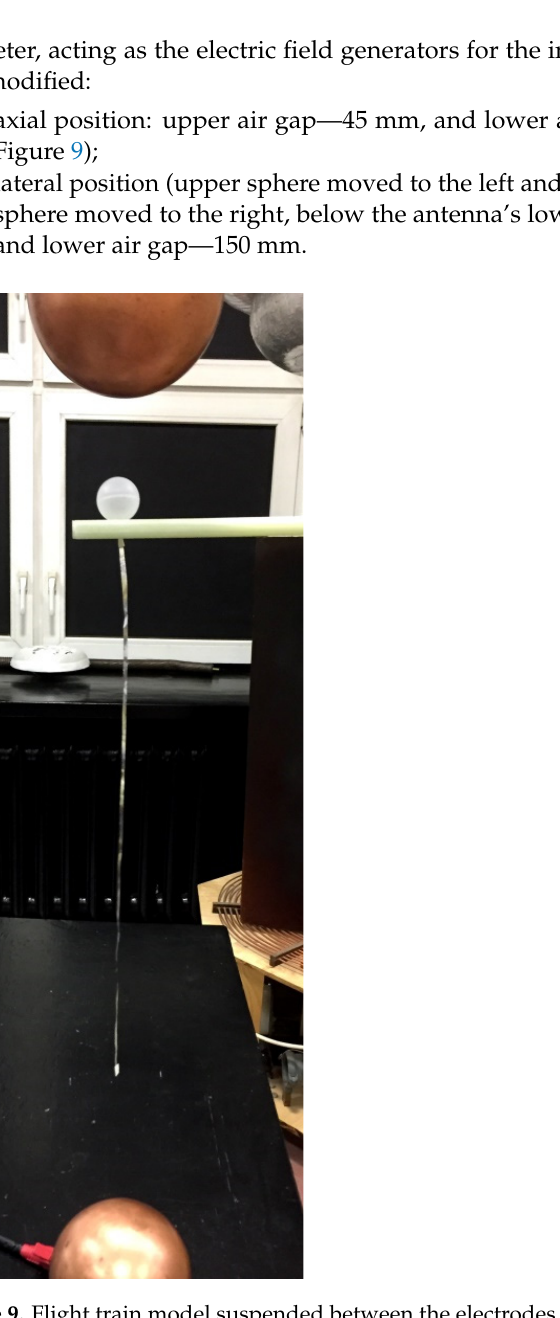
Figure 9. Flight train model suspended between the electrodes in the axial position. The weight/density of the model antenna wire was chosen so that it would be light enough to provide a high electrostatic-to-mass forces ratio, which allowed for the